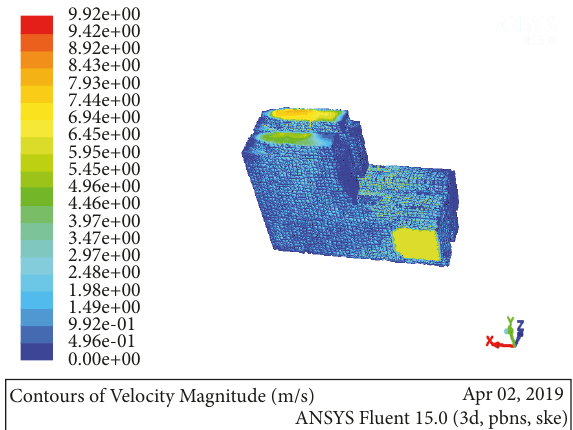
Figure 16: The velocity distribution of support in Test TS1.